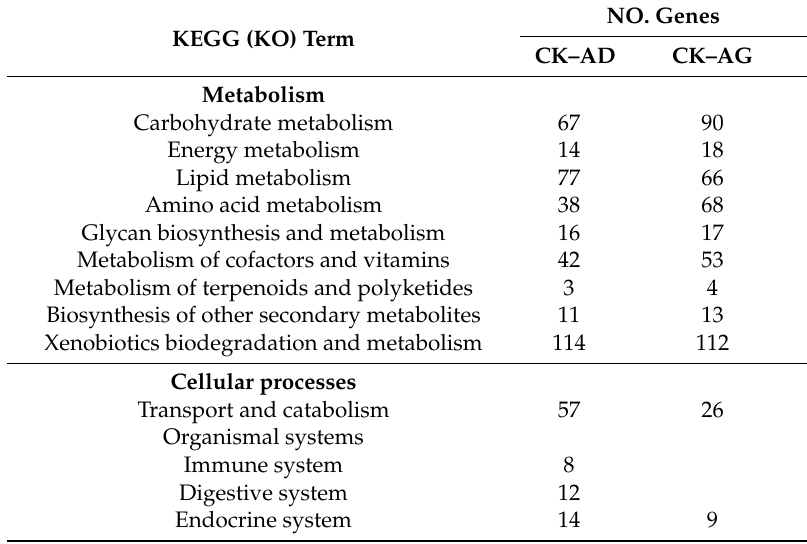
Table 4. Top 13 pathways involving DEGs in the AD and AG samples.